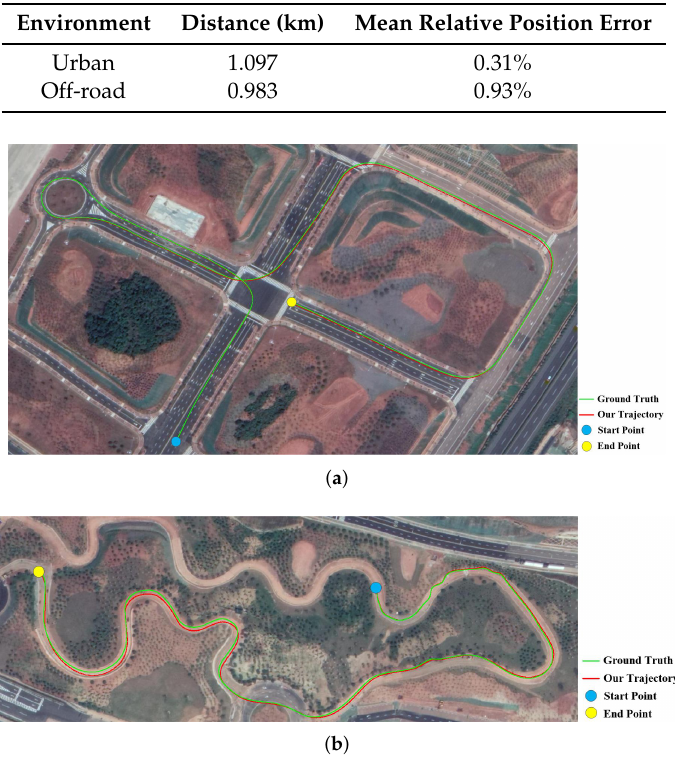
Figure 12. The results in the urban environment and off-road environment. ( a ) shows the trajectory generated in the urban environment when the UGV drives at a speed of around 25 km/h, and ( b ) shows the trajectory generated in the off-road environment when the UGV drives at a speed of around 15